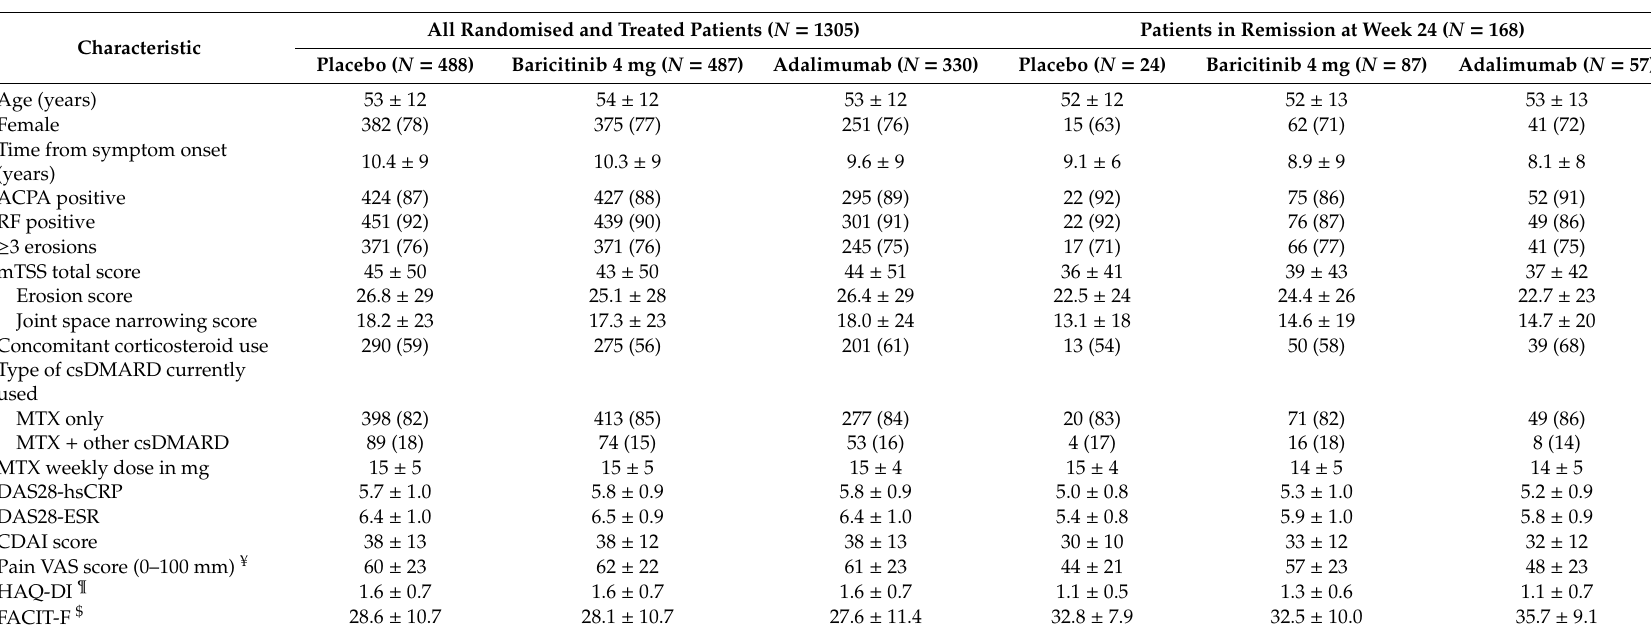
Table 2. Baseline characteristics of 1305 randomised and treated patients in RA-BEAM, and the 168 patients in remission (DAS28-ESR < 2.6) at week 24 [20].